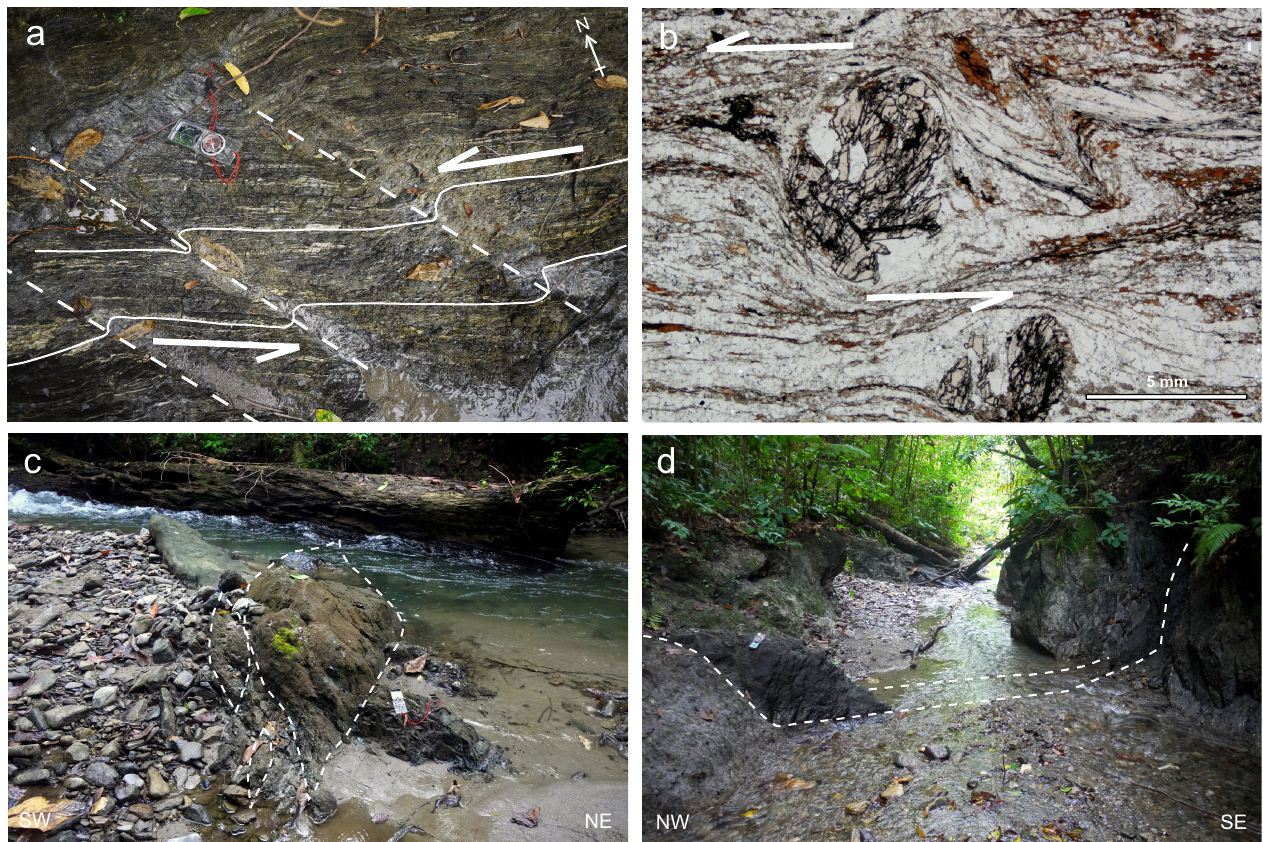
Fig. 13. The Kawa Shear Zone. (a) Left-lateral shear banding in garnet mica schists south of the Kawa Fault (129.0408 ◦ E, 3.0689 ◦ S); (b) σ -type garnet porphyroblasts record left-lateral shear in the garnet mica schists south of the Kawa Fault (129.0394 ◦ E, 3.0727 ◦ S); (c, d) Peridotite boudins within fault gouges and breccias just north of the inferred trace of the Kawa Fault are aligned to the 120–300 ◦ strike of the fault zone (129.0423 ◦ E, 3.0666 ◦ S and 129.0336 ◦ E, 3.0622 ◦ S,